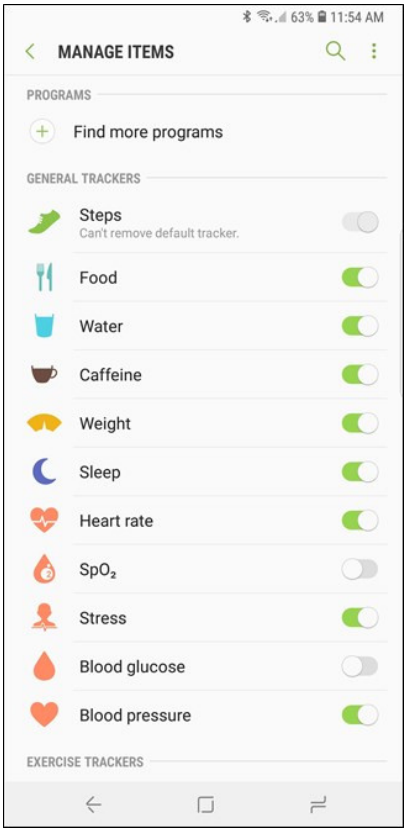
Figure 1. The screen of the Samsung Health Monitor application.